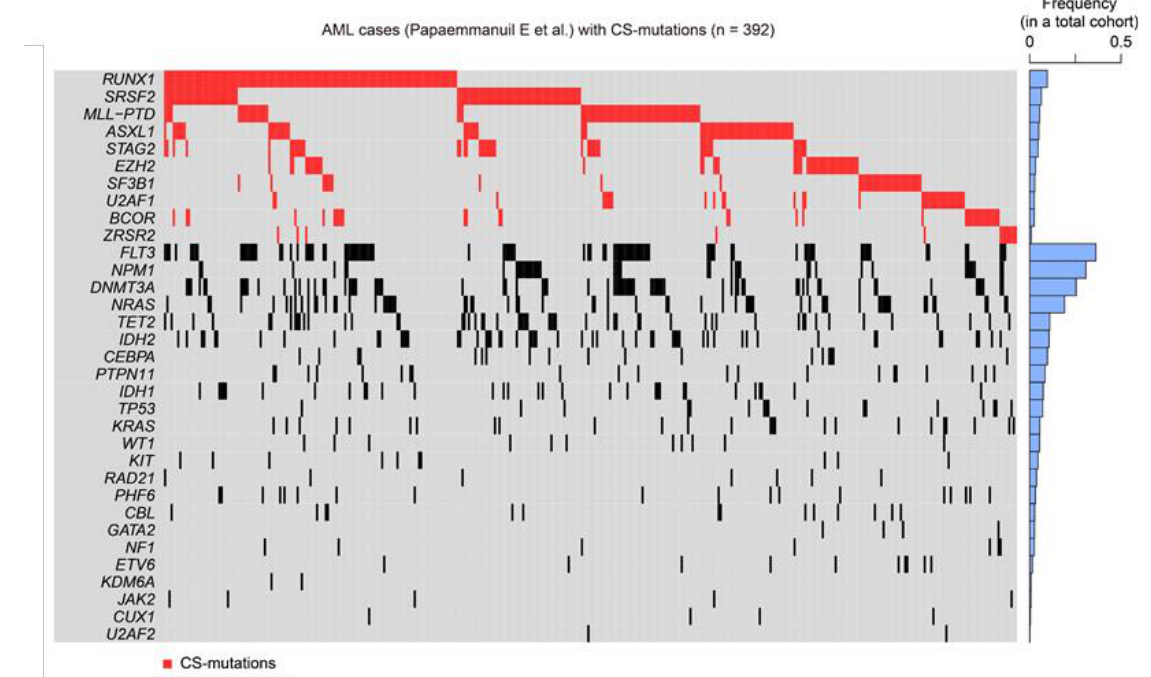
Figure 4. CS-mutations in AML. Heatmap representing CS-mutations found in a previous study [6]. Blue bars on the right show the frequency of each mutation in a large cohort of patients with AML (1540 cases). Not all cases demonstrated here satisfy the definition of CS-AML, as a subset of AML with CS-mutations is excluded from CS-AML due to presence of other class-defining mutations, as shown in Figure 1.